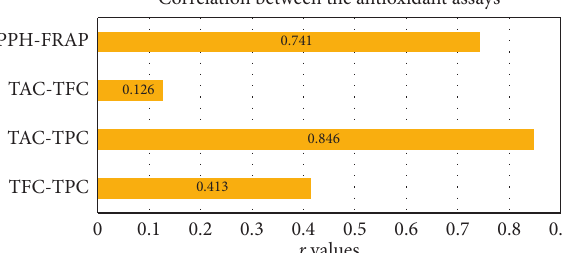
Figure 19: Correlation between antioxidant assays.